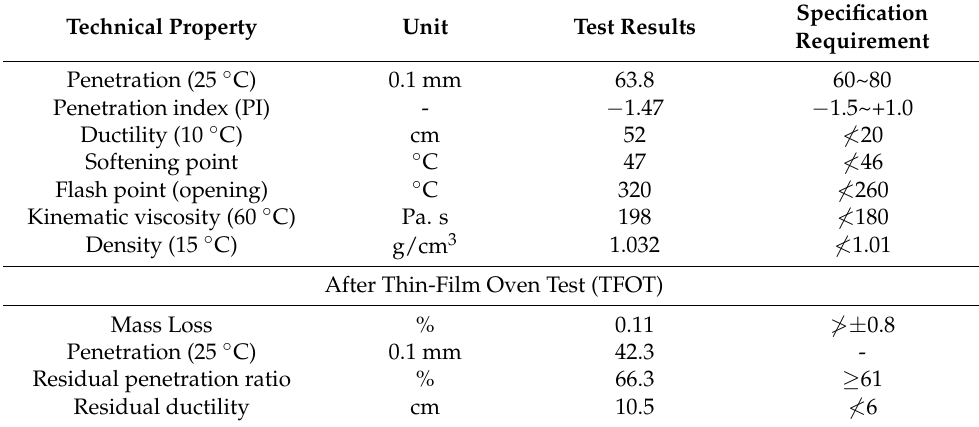
Table 3. Indexes of conventional asphalt